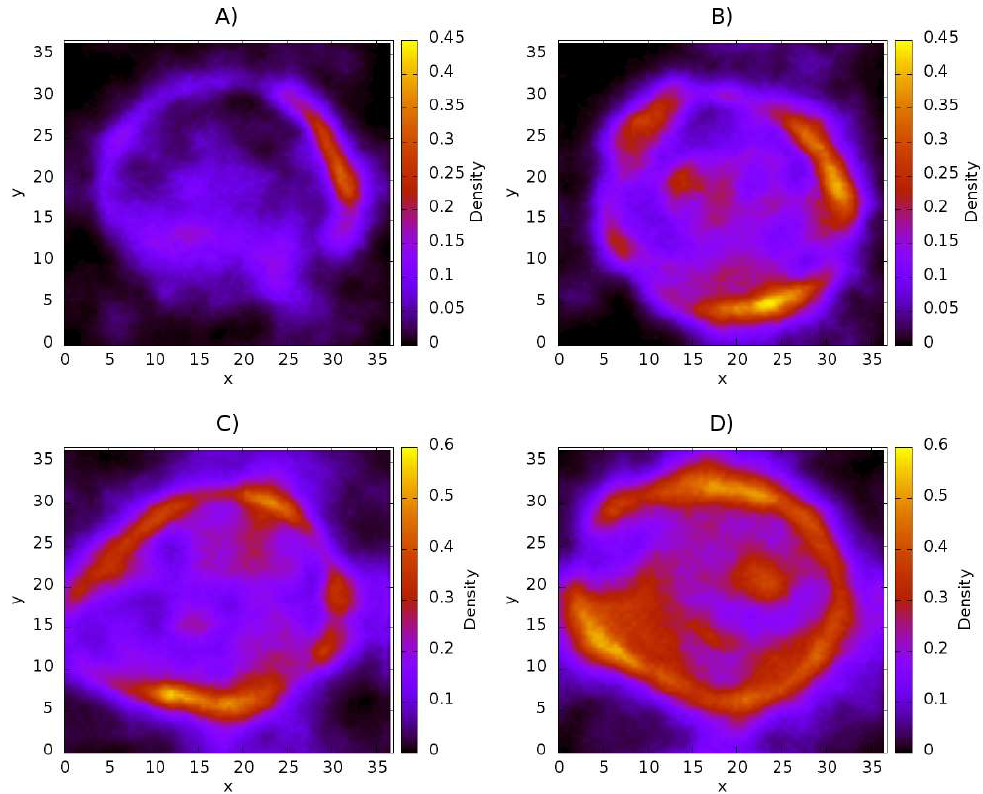
Figure 4. Distribution of CS on liposome on the xy plane. ( A ) 50 chains of CS; ( B ) 100 chains of CS; ( C ) 150 chains of CS; ( D ) 200 chains of CS. All quantities are reported in reduced DPD units.